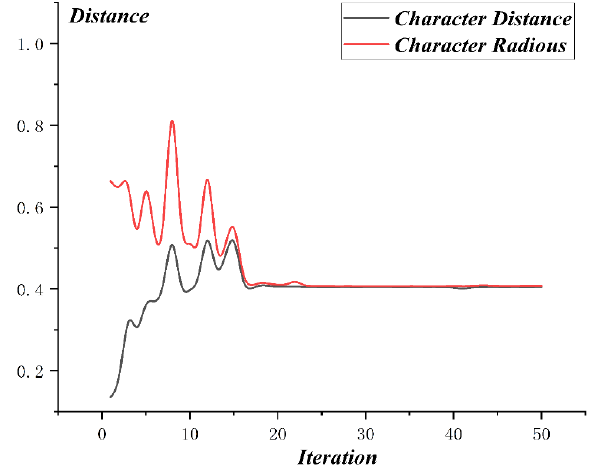
Figure 15. Relative distance of MO-GWO.